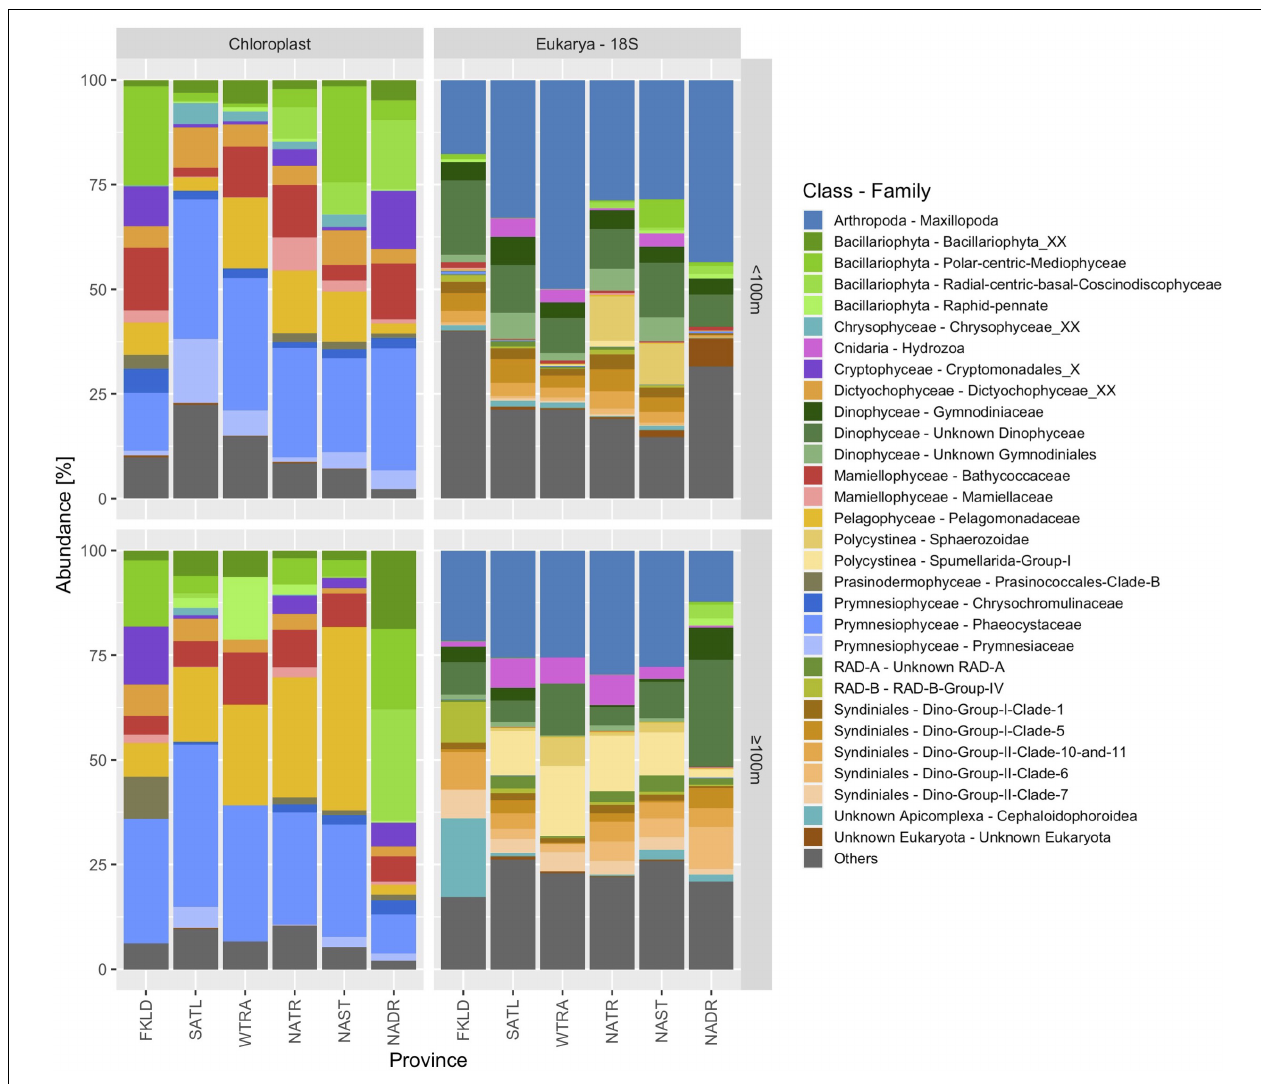
FIGURE 5 | Community composition of phototrophic algae (chloroplasts) and Eukarya (18S) in six biogeographical provinces of the Atlantic Ocean. Community composition based on chloroplast sequences was derived from 16S rRNA gene amplicons and Eukarya from 18S rRNA gene amplicons using the universal primer set V4-V5. The size fraction > 8 µ m was used for this analysis. Samples were pooled into two depth groups < 100 m and ≥ 100